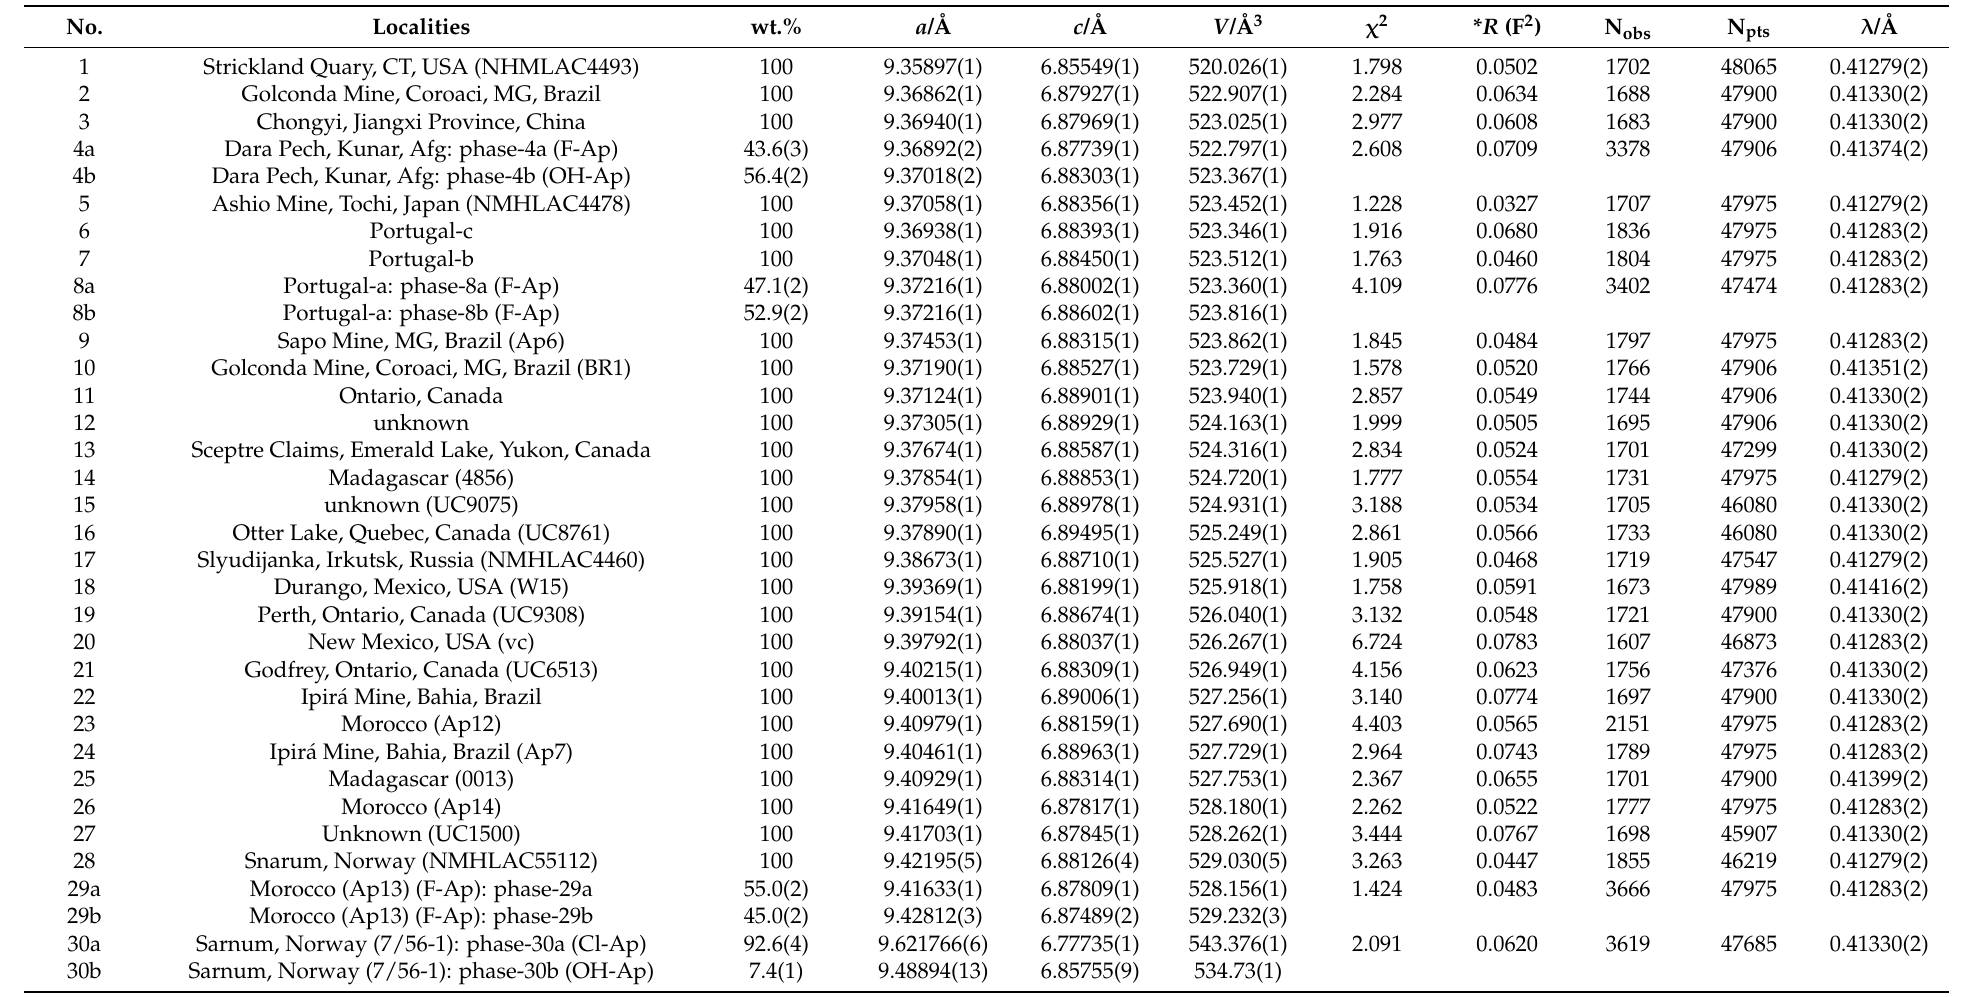
Table 1. Locality †, wt.%, unit-cell parameters, and Rietveld refinement statistical indicators, R (F 2 ), χ 2 , N obs , N pts , and λ for 33 apatite